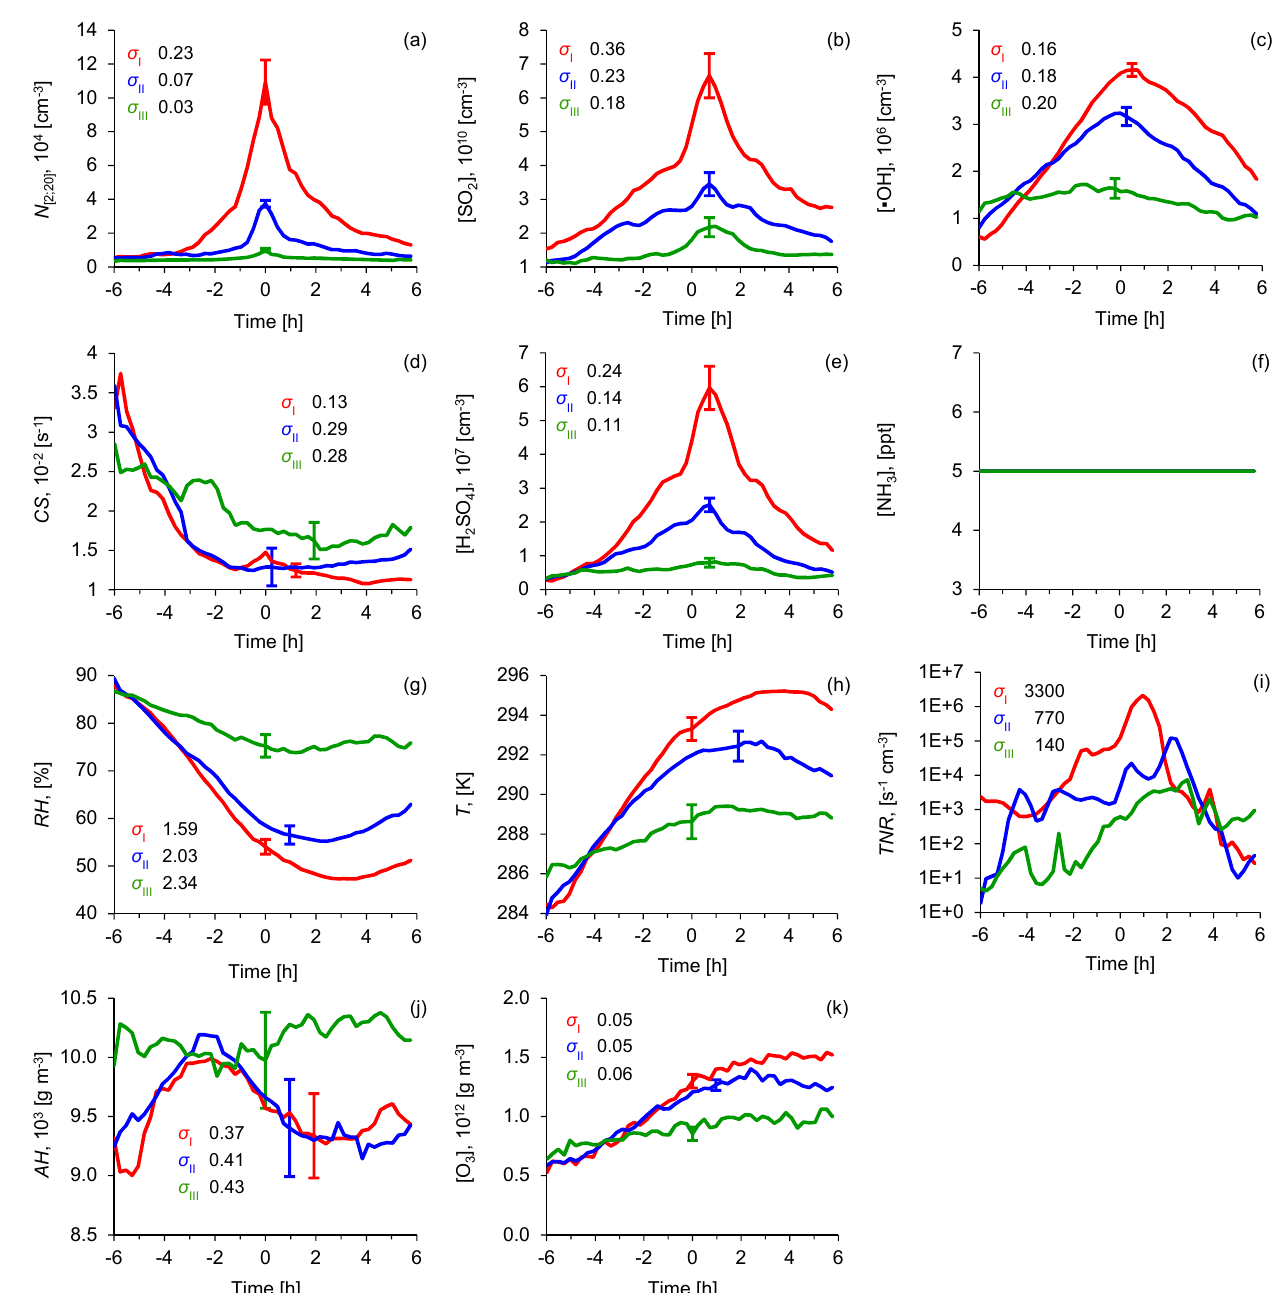
Figure 6. Average diurnal cycles of atmospheric parameters for the three NPF event classes: red indicates a Class I event, blue indicates a Class II event, and green indicates Class III (weak events and “non-events”). The subfigures show concentrations of (a) ultrafine particles (cid:113) ( N [2;20] ), (b) sulfur dioxide (SO 2 ), (c) hydroxyl radicals ( OH), (d) the condensational sink (CS), (e) calculated sulfuric acid (H 2 SO 4 ), and (f) ammonia (NH 3 ) using a constant value of 5ppt, (g) relative humidity (RH), (h) temperature ( T ), (i) ternary nucleation rates (TNR) calculated according to Napari et al. (2002) and under the assumption of a constant ammonia concentration [NH 3 ] = 5ppt, (j) absolute humidity (AH), and (k) ozone (O 3 ) concentrations. Data coverage: Class I (55 days), Class II (60 days), Class III (67 days). The σ values, √ n − 1.) The indicated by whiskers, represent the standard error of the mean of each subpopulation. (Technically, this is calculated as σ/ arithmetic means of the event peak times were 10:48CET for Class I, 11:54CET for Class II, and 11:46CET for Class